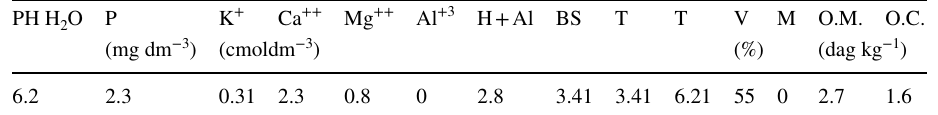
characterization of the red Eutrophic Oxisol